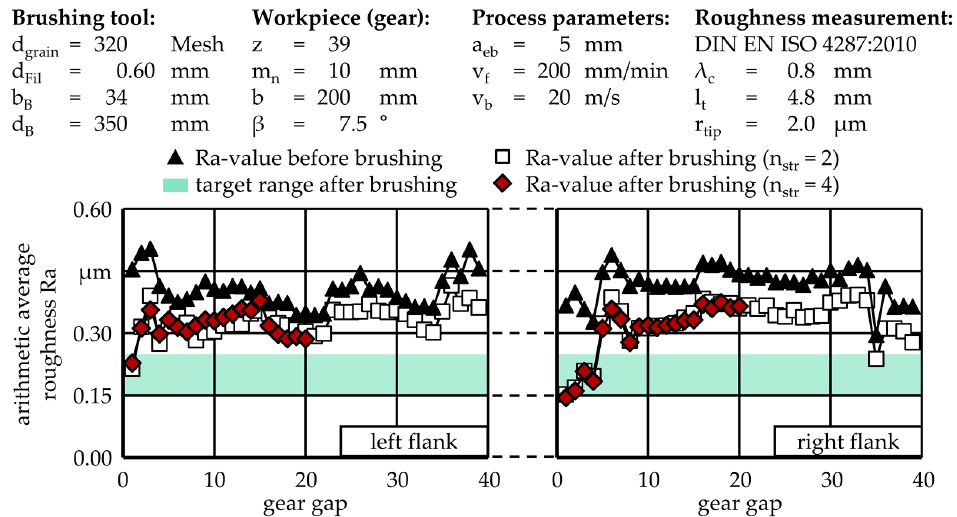
Figure 5. Comparison of the arithmetic average roughness Ra before and after the brushing process for the test series with tool specification S320x0.60 and an initial roughness of Ra ini ≅ 0.4 μ m. To qualitatively assess the wear of the brush filaments on a microscopic level, micro- scopies of individual filaments were taken after different processing times. When looking at the microscopic images of the individual filaments (S320x0.60) in Figure 7, it becomes clear that wear sets in rapidly and that the filament tips in particular are flattened after a short time. This correlates with the findings on the tool life of the S320x0.60 brushing tool. Consequently, there seems to be a direct correlation between the cutting ability of the filament tips and the removal rate of the entire brushing